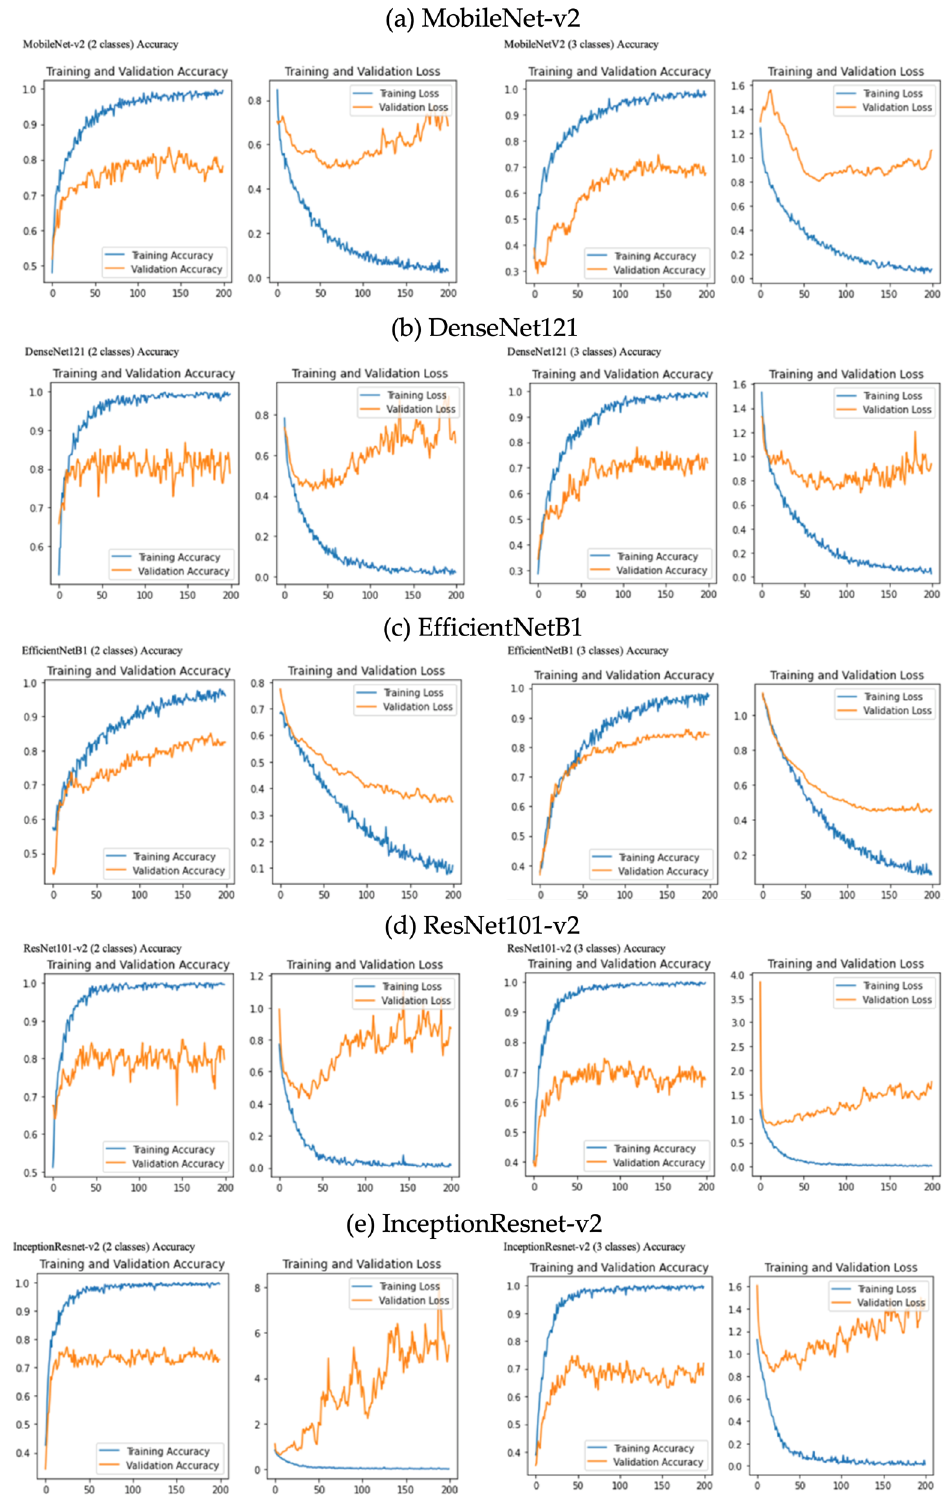
Figure 8. Examples of CNN training and validation accuracy models: ( a ) MobileNet-v2, ( b ) DenseNet121, ( c ) EfficientNetB1, ( d ) ResNet101-v2, and ( e ) InceptionResnet-v2.